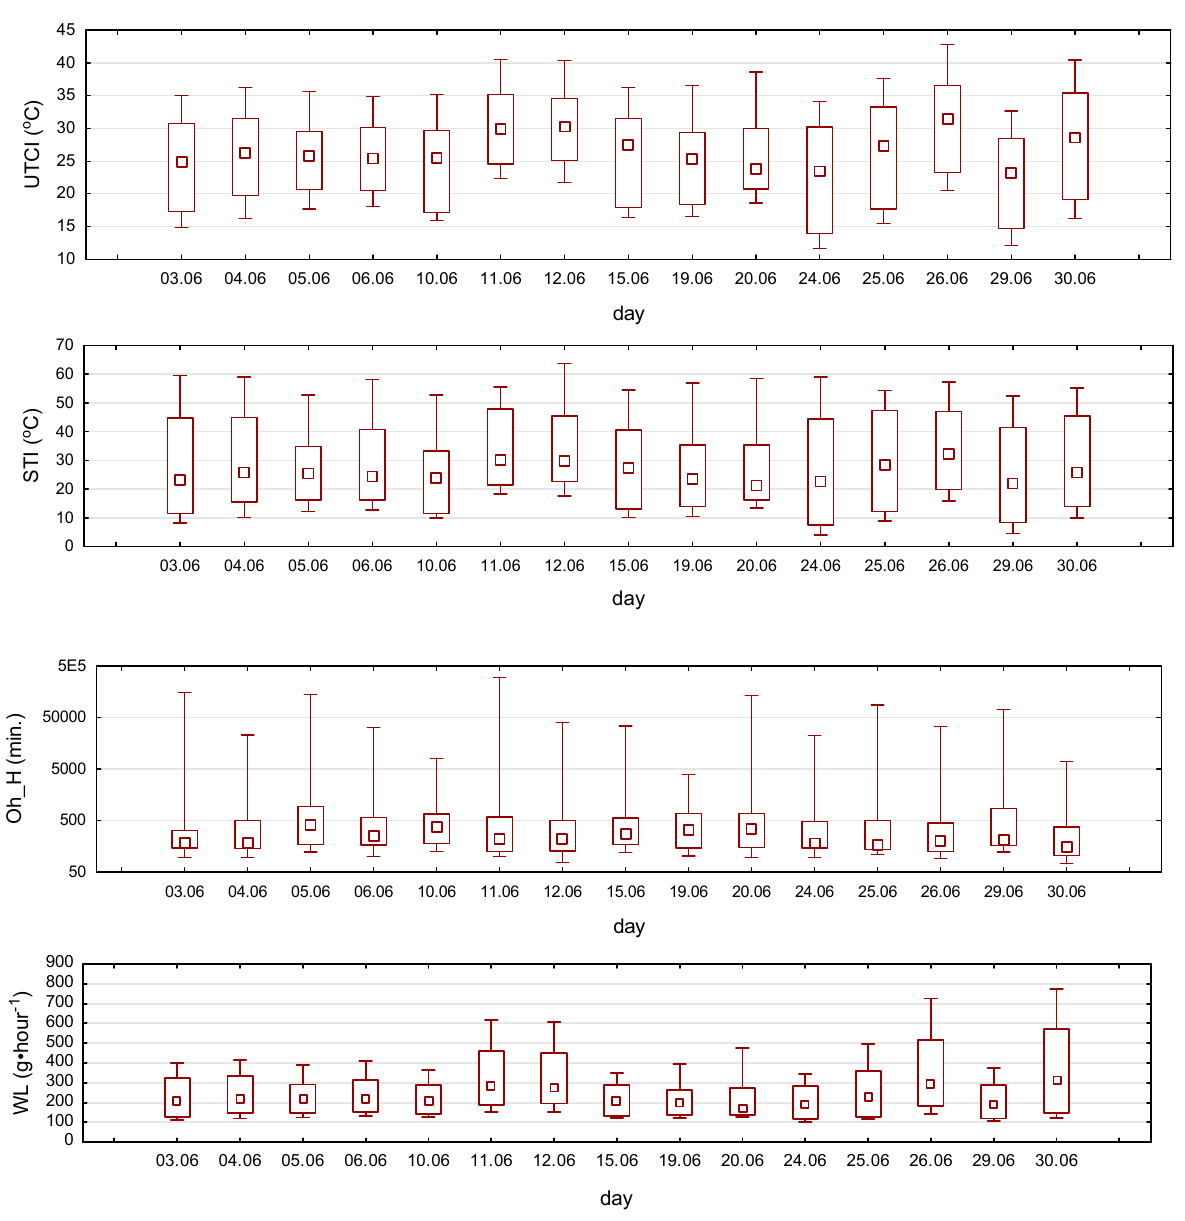
Figure 5. Median, lower and upper quartiles, as well as the maximum and minimum of UTCI, STI, Oh_H (no “unlimited” situation), SW and OV in Bydgoszcz on hot days in June